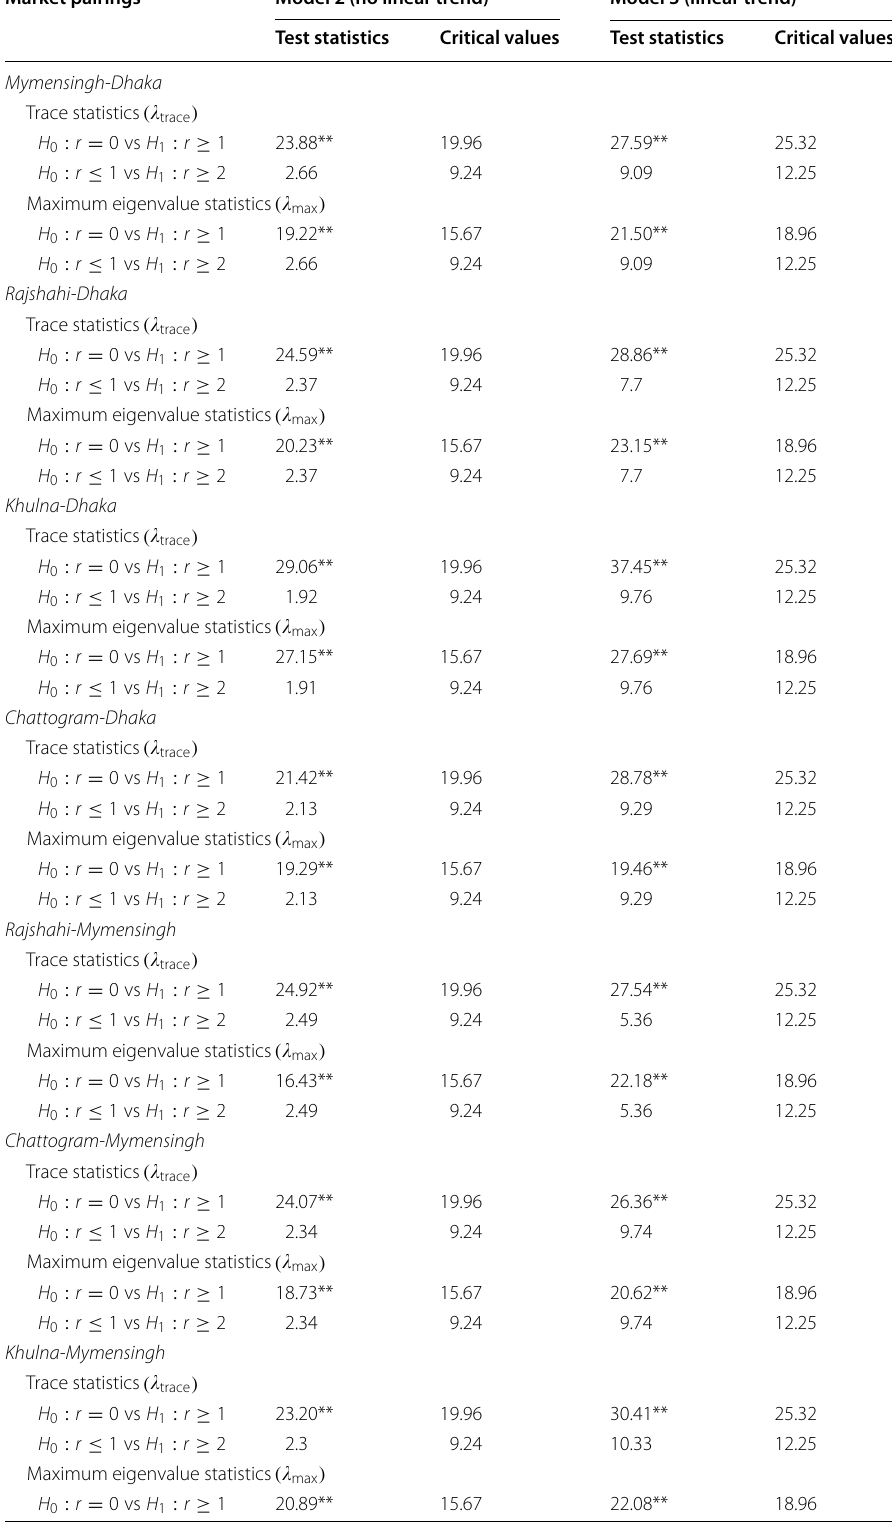
Table 3 Johansen cointegration test results Market pairings Model 2 (no linear trend) Model 3 (linear trend) Test statistics Critical values Test statistics Critical